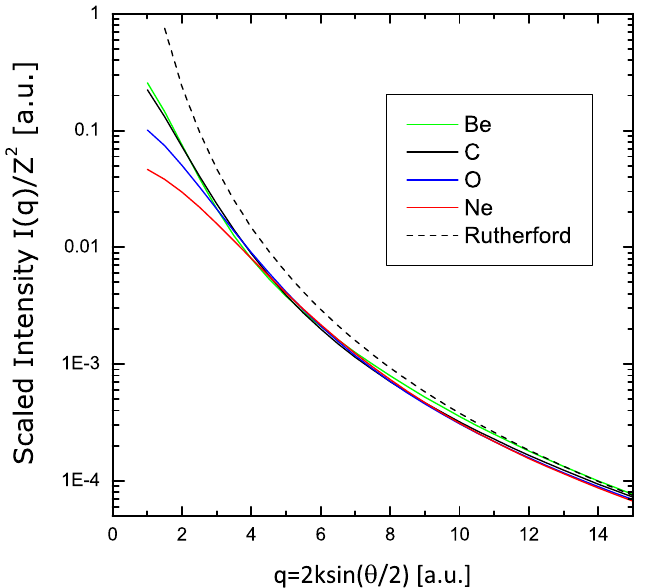
Figure 8. Scaling of the scattering intensity using the same calculations of Figure 7, plotted here in form I ( q ) / Z 2 , showing the asymptotic convergence to the Rutherford limit 4/ q 4